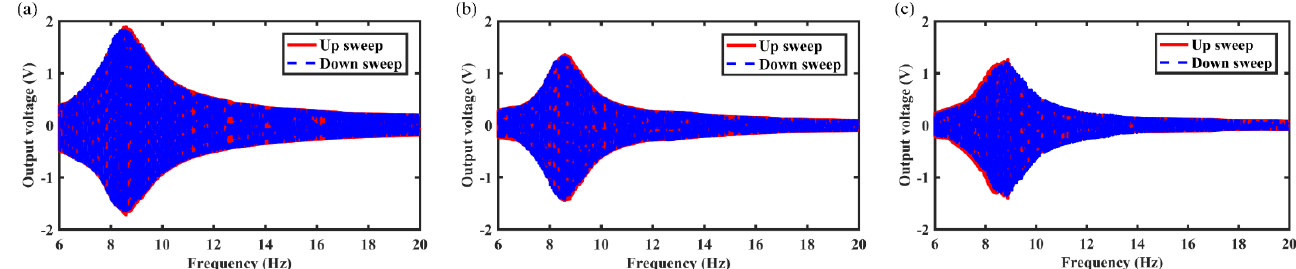
Figure 8. Frequency sweep response of the MCEEH with spring wire diameter of 0.4 mm: ( a ) coil 1; ( b ) coil 2; ( c ) coil 3.